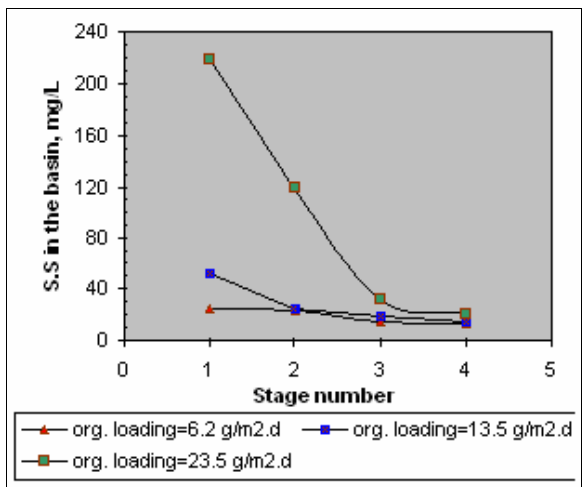
Figure 18: Relationship between the concentrations of suspended solids and organic loading at different stages of RBC